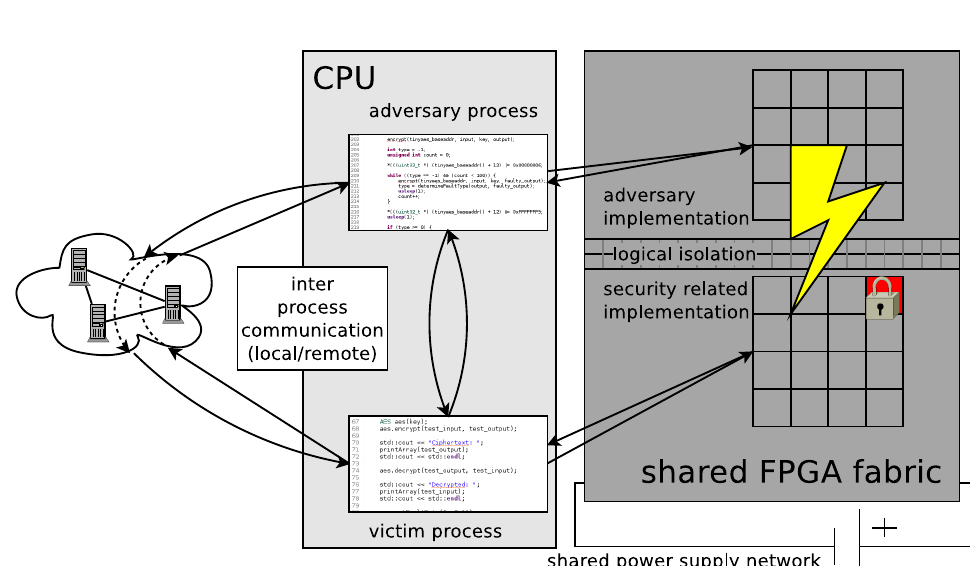
Figure 1: Overview of the threat model considered in this work: Attacker and victim share an FPGA resource with a common power supply network, but isolated, logically disconnected partitions on the